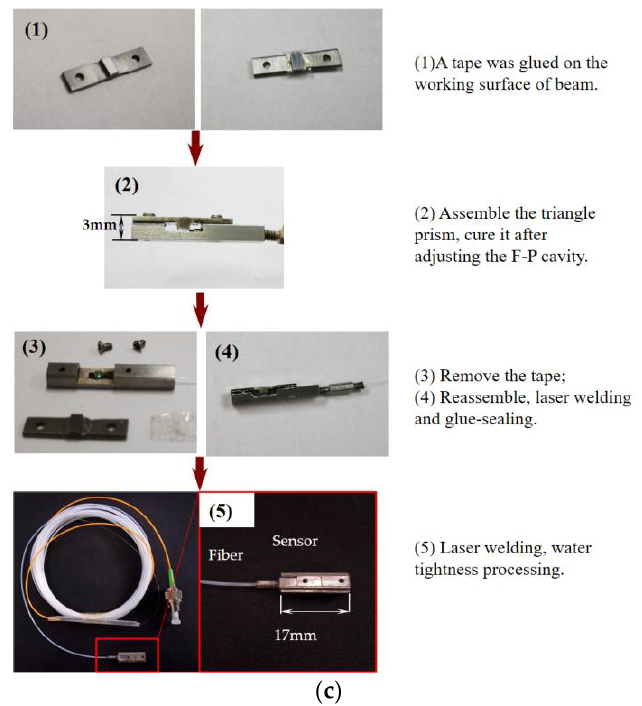
Figure 5. ( a ) All elements of the sensor, ( b ) the sensor signal monitoring system, ( c ) the preparation process of the sensor. There are five key steps in the sensor production.